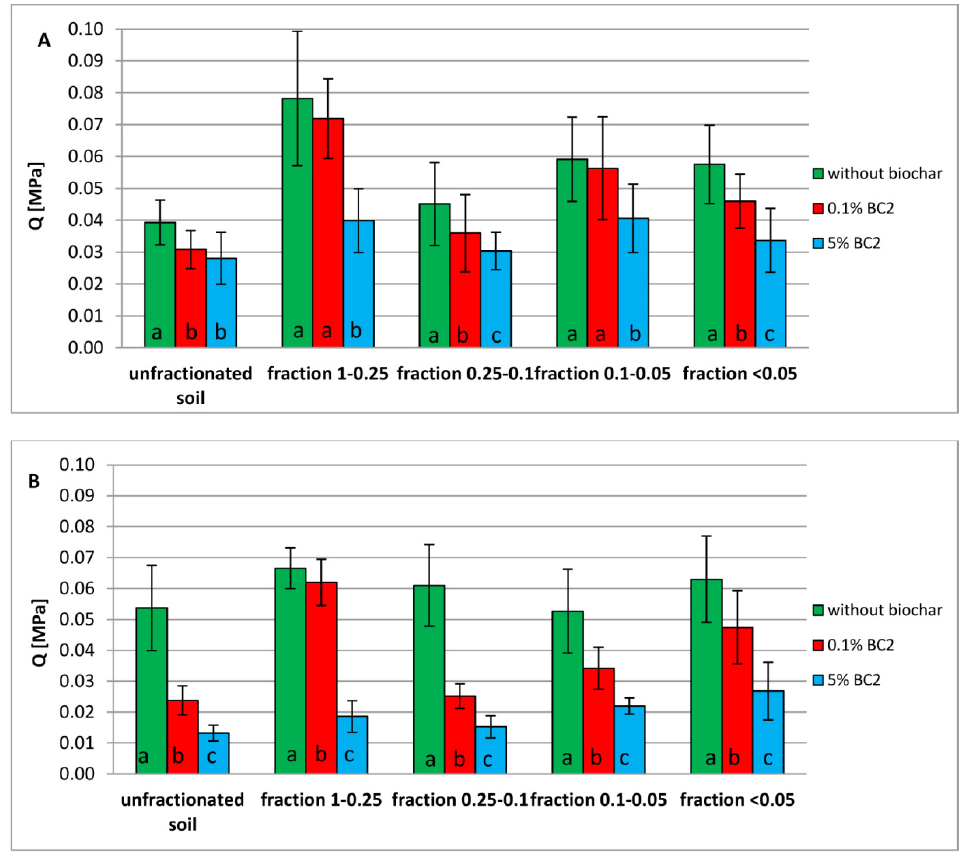
Figure 10. Sunflower husk biochar (BC2) effect on the tensile strength of air-dried ( A ) and wetted ( B ) cylinders formed from the unfractionated soil and its selected fractions; the bars correspond to the standard deviation.